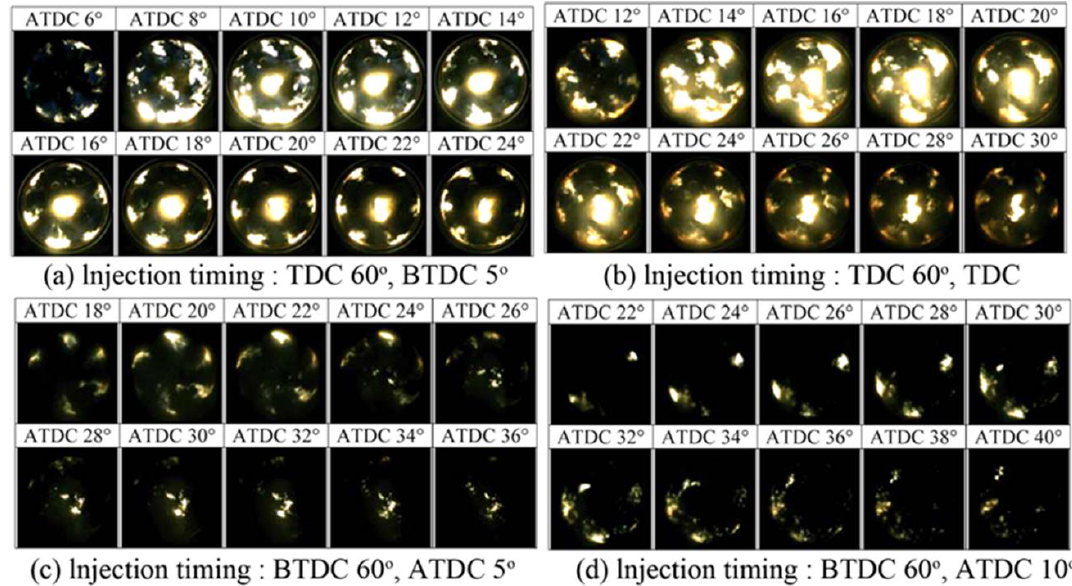
Figure 9. Flame characteristics as a function of second injection timing change [79]. ( a – d ): different second injection timing, the images of flame change with crank angle.